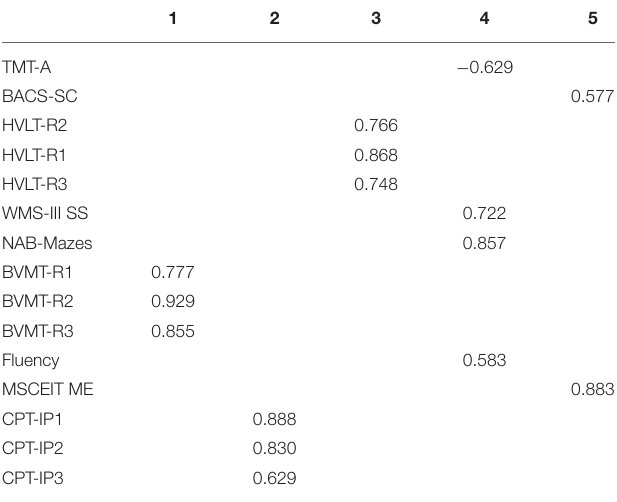
TABLE 3 | EFA of MCCB in Y-MDD